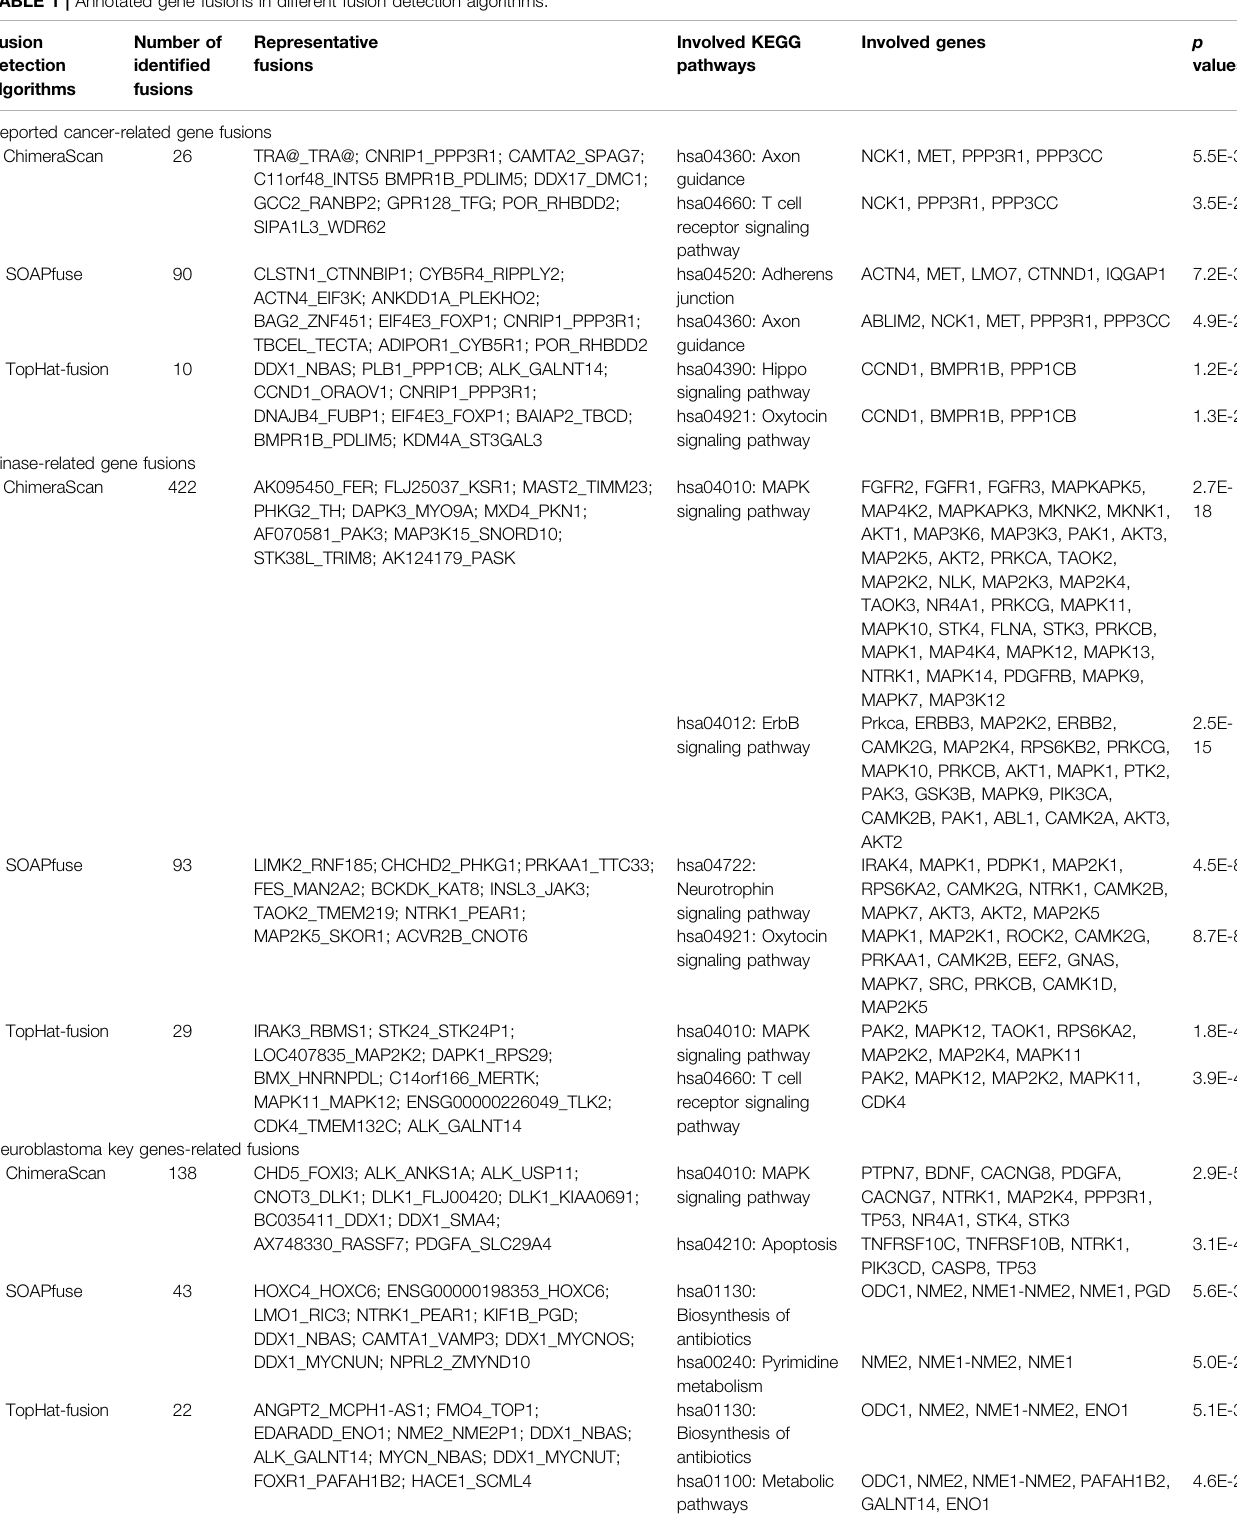
TABLE 1 | Annotated gene fusions in different fusion detection